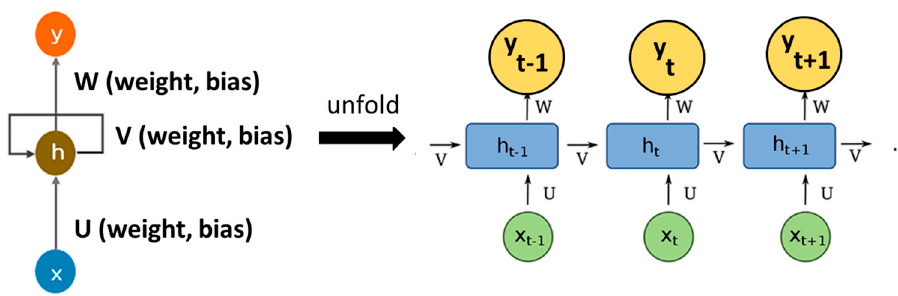
Figure 8. RNN basic architecture.